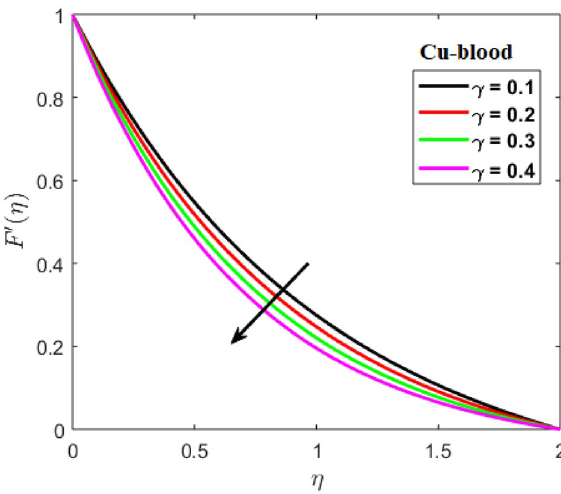
Figure 2. Results of γ on